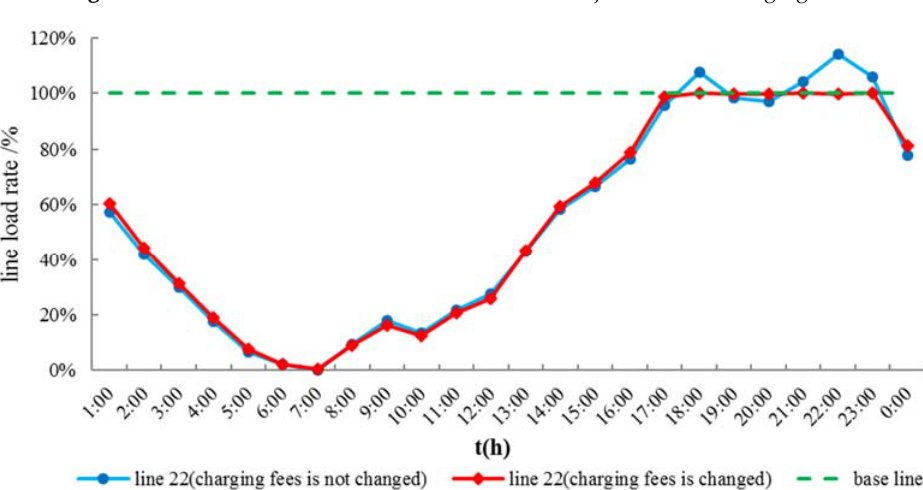
Figure A3. Line load rate of line 22 before and after adjustment for charging fees.